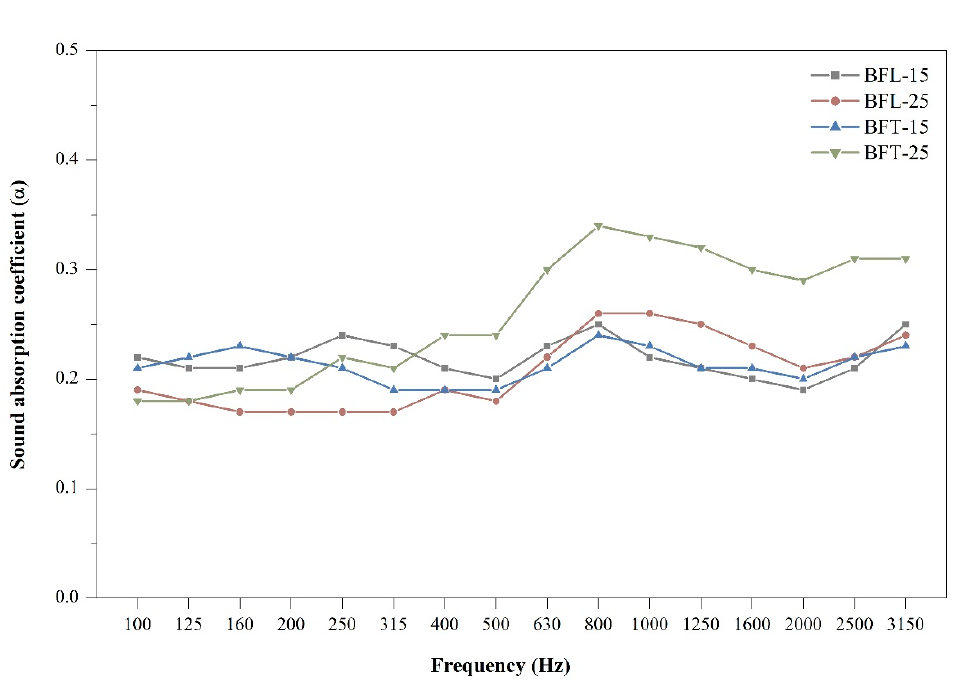
Figure 11. The sound absorption coefficient of Buriti foam samples.